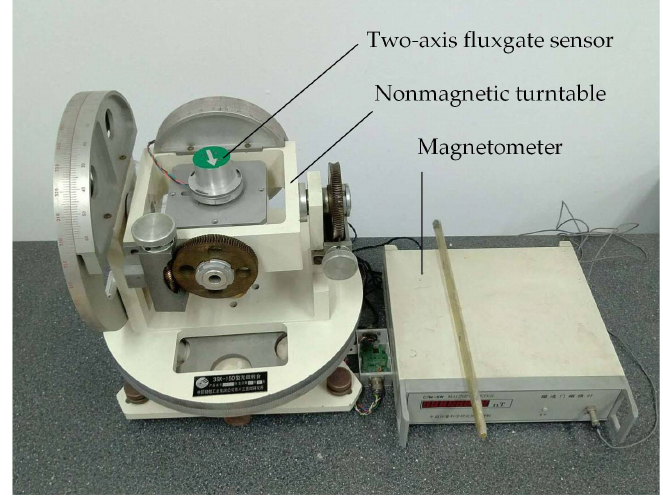
Figure 2. Experimental platform.